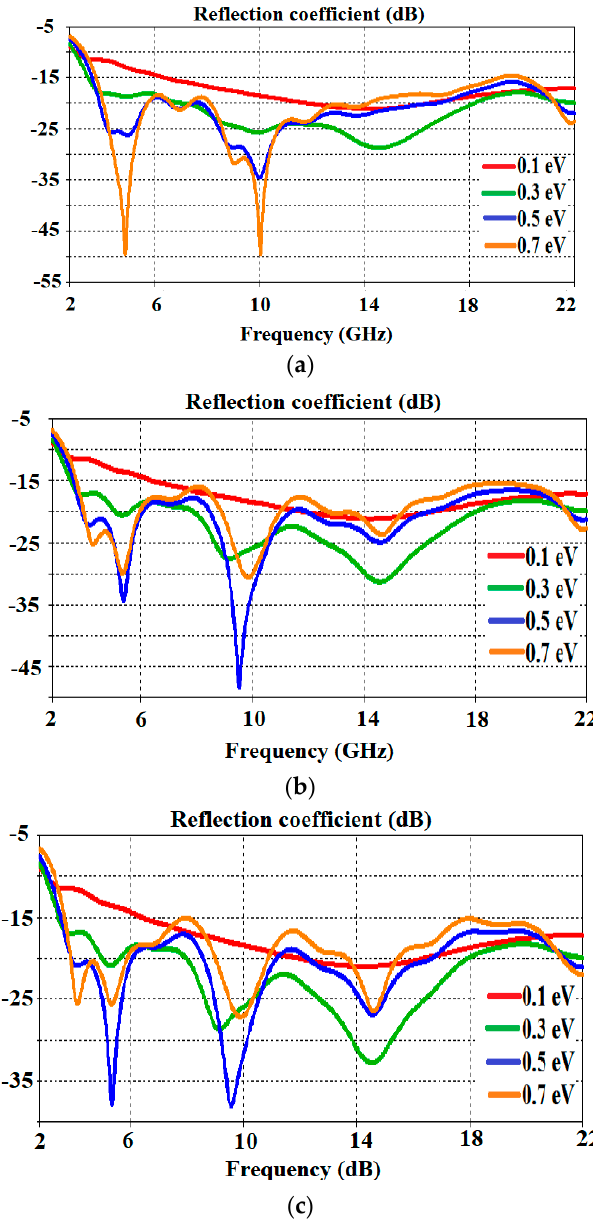
Figure 8. Reflection coefficient of ( a ) Antenna-1, ( b ) Antenna-2, and ( c ) Antenna-3 for varying chemical potential.